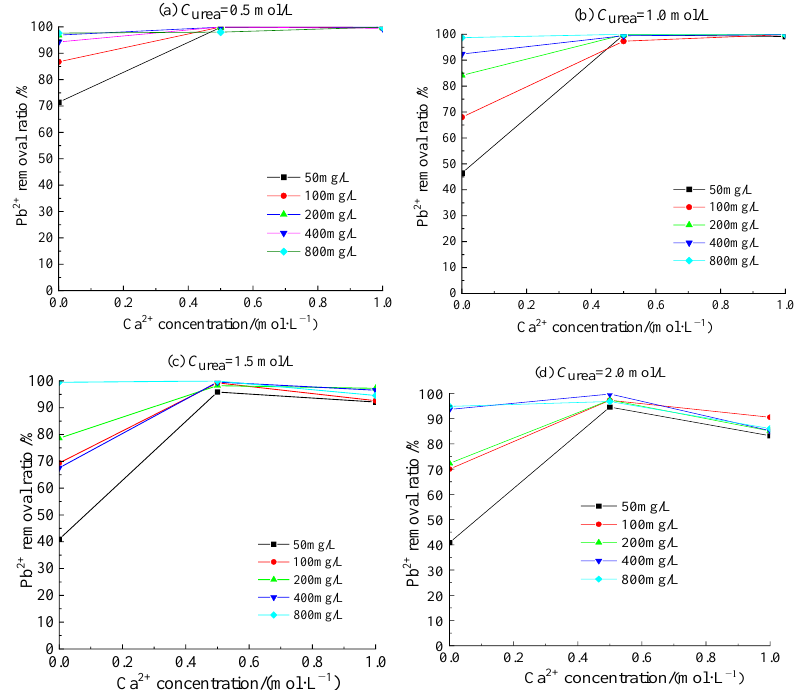
Figure 8. Removal ratio of Pb 2+ with different urea concentrations (( a ) C urea = 0.5 mol/L; ( b ) C urea = 1.0 mol/L; ( c ) C urea = 1.5 mol/L; ( d ) C urea = 2.0